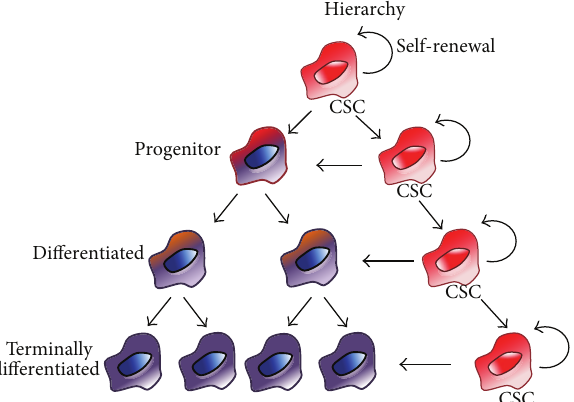
Figure 1: The CSC model. Over time, CSCs acquire phenotypes and characteristics of normal stem cells such as unlimited self-renewal and the capacity to divide indefinitely and at the same time maintain the ability to generate multiple cell lineages, including differentiated progenies. A CSC can thus divide (1) asymmetrically (differentia- tion) giving rise to one CSC and a specialized differentiated cell or (2)symmetrically(self-renewal)givingrisetotwoidenticalCSCs.In both cases, the capacity of self-renewal remains intact and ensures the survival of the CSC pool and supports the hierarchical model of tumor cell